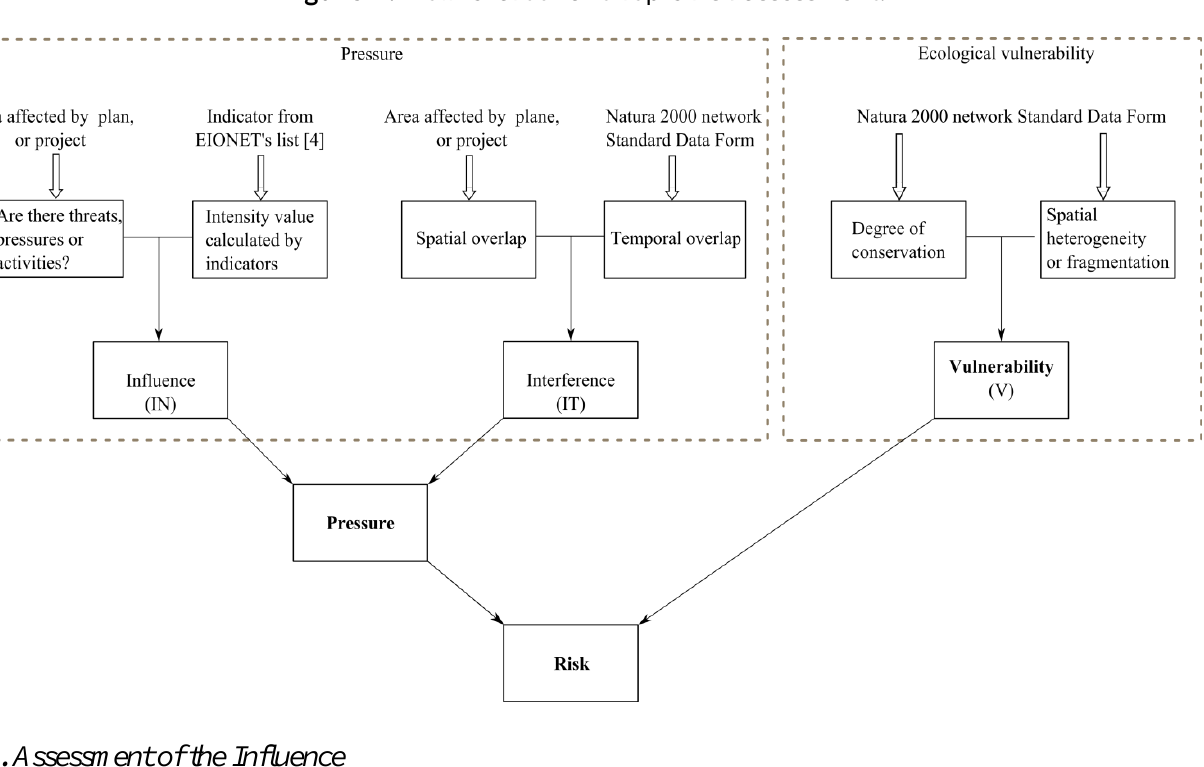
Figure 4. Flow chart of anthropic risk